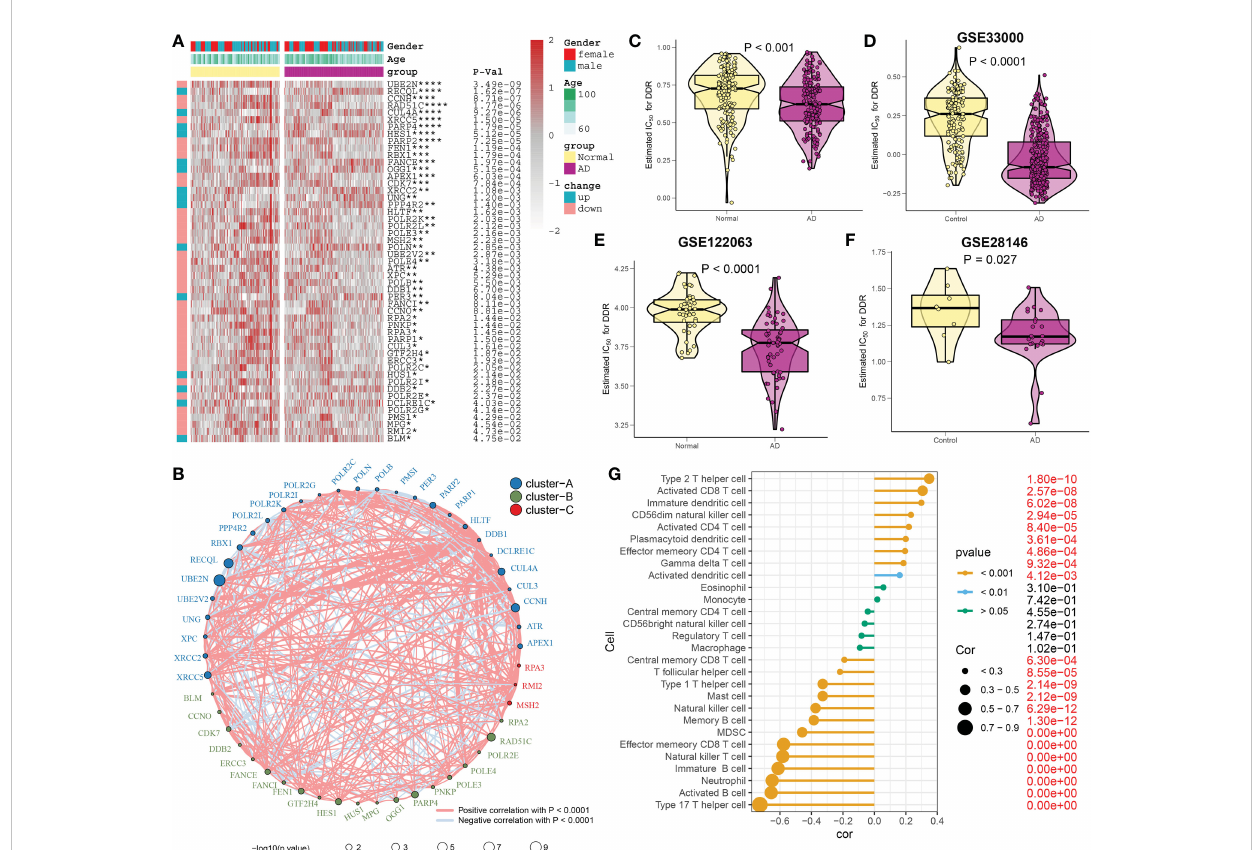
FIGURE 2 Estimation of DDR regulators between AD and healthy individuals. (A) Comparison of the expression pro fi les of abnormal DDR regulators across AD and non-AD brain tissues in combined dataset using a heatmap. As examples of annotations, age and sex were displayed. (B) Interactions among 51 DDR regulators. The circle size serves as a representation of how each individual variable affected AD, and the Benjamini-Hochberg method is used to modify the p-value. Different colors indicating that DDR regulators are grouped into distinct clusters. The interactions are represented by each line joining the DDR regulators, and the thickness of each line re fl ected the intensity of the link. Blue denotes a negative correlation, whereas red denotes a positive connection. (C – F) The DDR scores of AD and non-AD brain tissues are compared in the combined datasets (C) , GSE33000 (D) , GSE122063 (E) , and GSE28146 (F) respectively. (G) The relationship between 28 immune cell subtypes and the DDR score in combined dataset. *p < 0.05, **p < 0.01, ***p < 0.001, ****p <